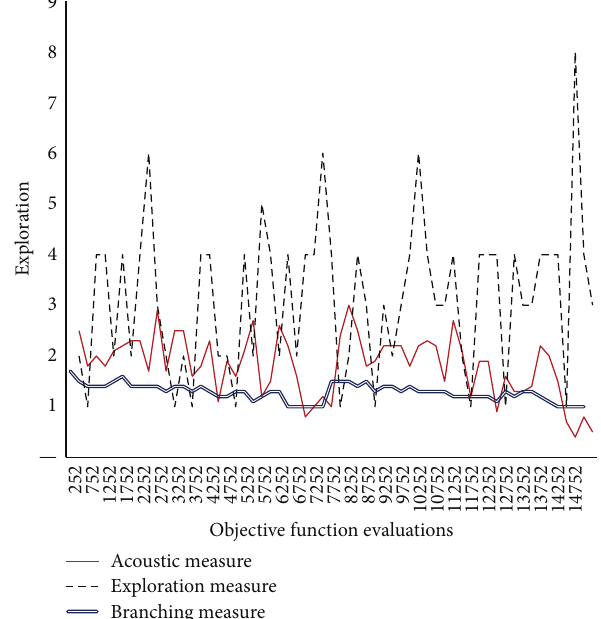
Figure 4: Evaluating ACO ustic against traditional indicators in ACO for the TSP instance d198 with nearest neighbourhood thresh- old = 𝜖